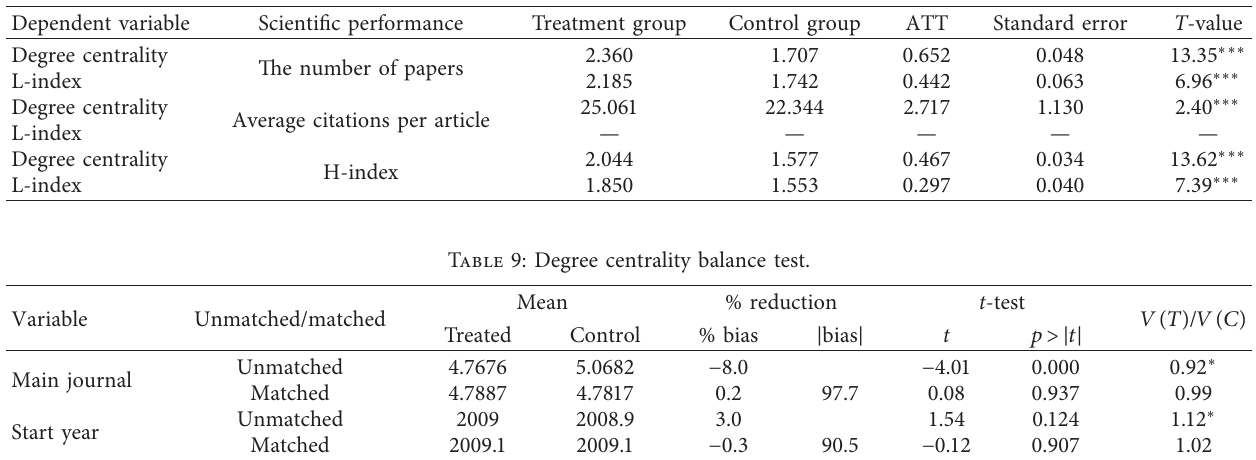
Table 8: Propensity score matching results.